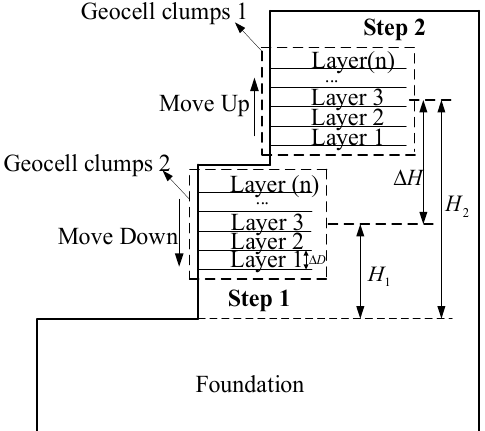
Figure 8. Schematic diagram of the test.